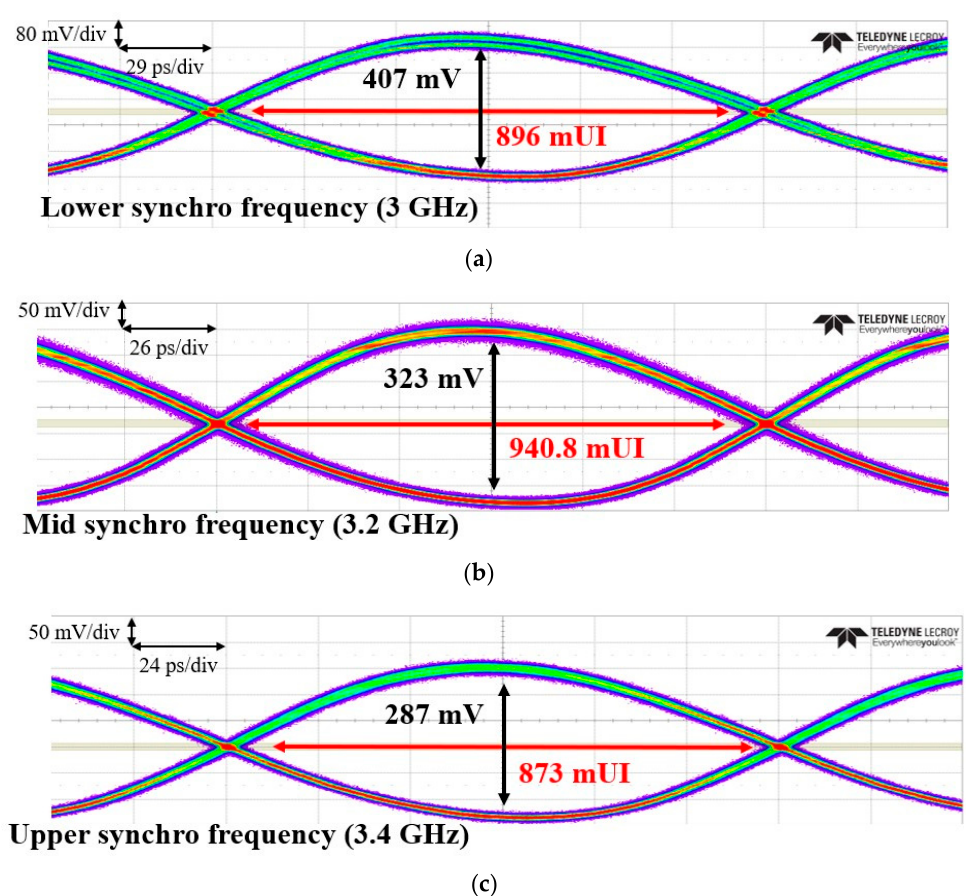
Figure 13. Eye diagram comparison of the PLL synchronized by injection at the ( a ) lower, ( b ) mid-range, and ( c ) upper capture range.